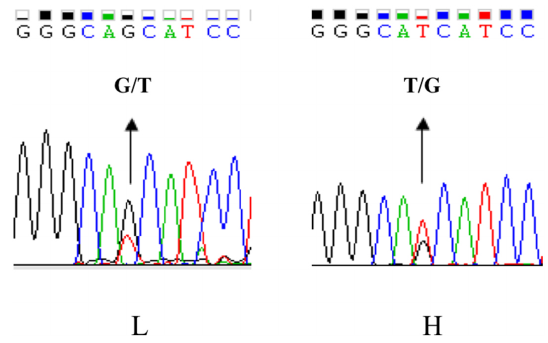
Figure 2. The SNP identification of UBXN1 promoter region by direct sequencing in porcine longissimus dorsi muscle. Partial chro- matograms represented the SNP ca. − 379T > G in the UBXN1 pro- moter